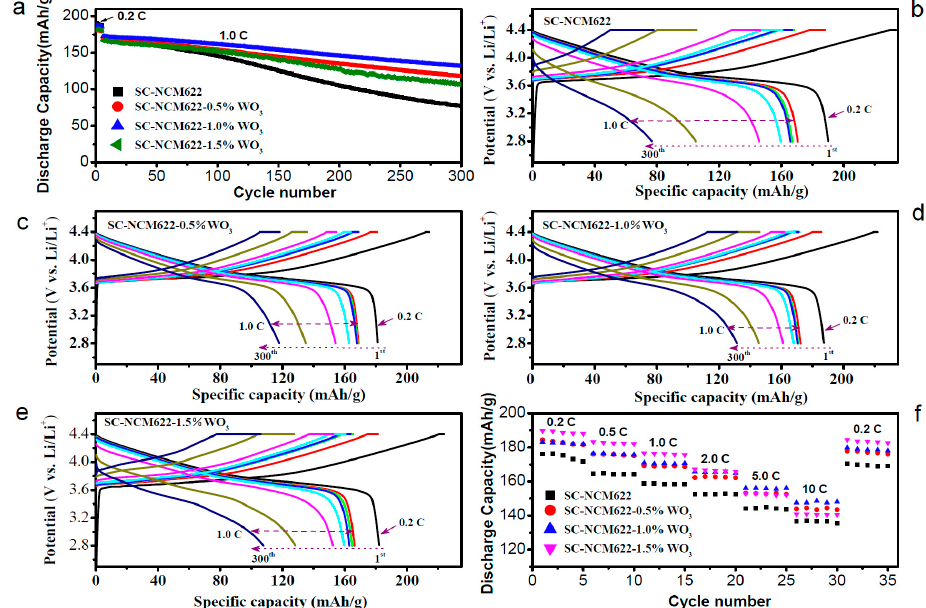
Figure 5. ( a ) Cycle performance of all the samples at 0.2 C rate for the first 5 cycles and 1.0 C rate for subsequent cycles over 2.8–4.4 V. Corresponding charge–discharge curves at the 1st, 6th, 15th, 20th, 50th, 100th, 200th and 300th cycles for ( b ) SC-NCM622, ( c ) SC-NCM622-0.5%WO 3 , ( d ) SC-NCM622-1.0%WO 3 and ( e ) SC-NCM622-1.5%WO 3 . ( f ) Rate capabilities of all the samples over 2.8–4.4